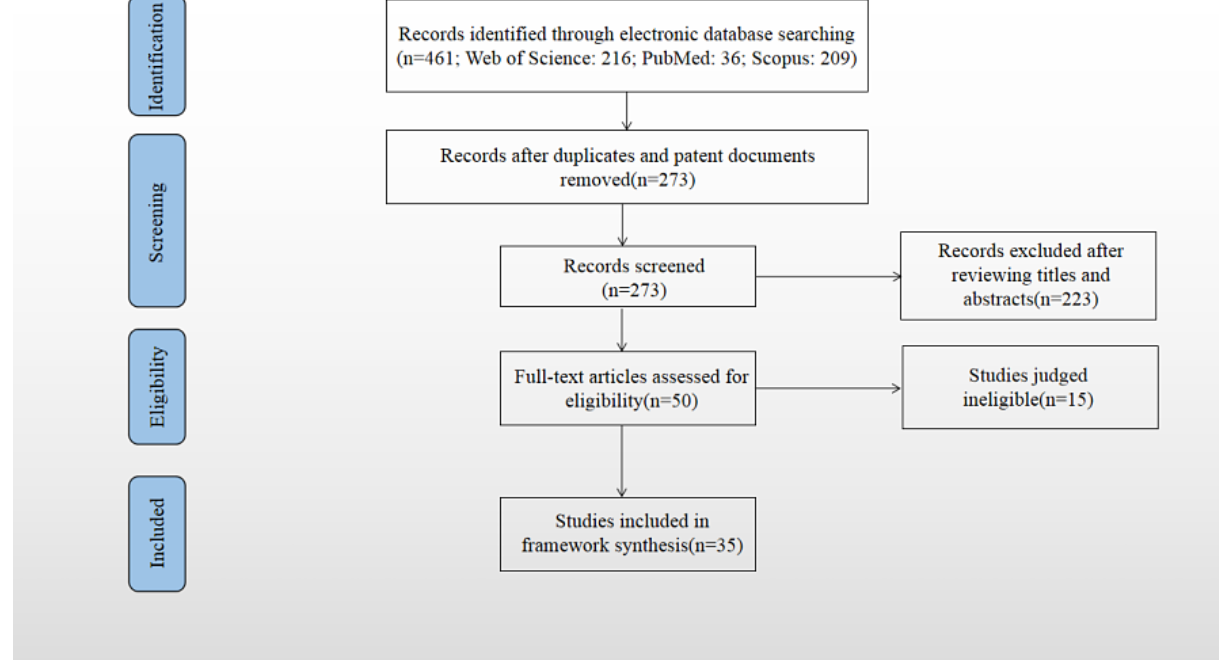
Figure 1. The Preferred Reporting Items for Systematic Reviews and Meta-Analyses flow